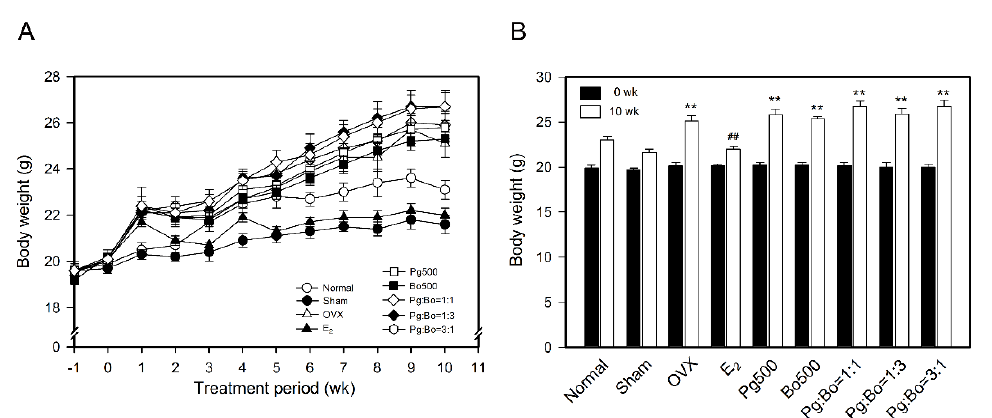
Figure 2. Effect of Pg and Bo on body weight of OVX mice. ( A,B ) Body weight was measured from the day of operation (−1 week) till the end of experiment (10 weeks) every week ( n = 10). Normal, Sham, and OVX groups received water and sample treated groups received total 500 mg/kg/day of Pg, Bo, and Pg:Bo combination. All values are expressed as mean ± standard error of mean (SEM). ** p < 0.01 versus Sham, ## p < 0.01 compared with OVX.